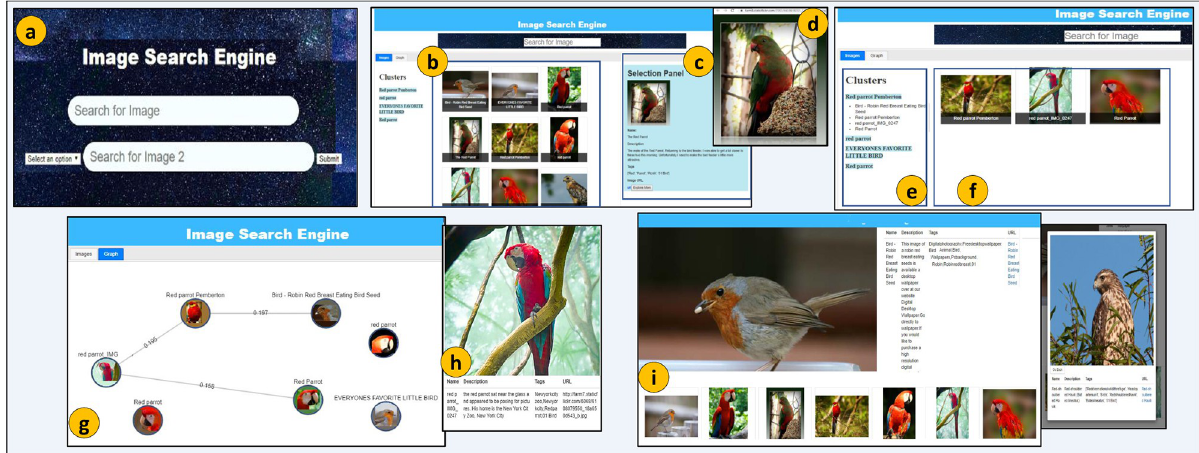
Fig 4. Query Formulation Panel (QFP) ( a ), Result Grid Panel (RGP) ( b ), Selection Panel (SP) ( c ), access of image result from the actual web source ( d ), Cluster List Panel (CLP) ( e ), Cluster-Graph Panel (CGP) ( f ) Graph Visualization Panel (GVP) ( g ), Information Window ( h ), and Related Results Panel (RRP) ( i ) of